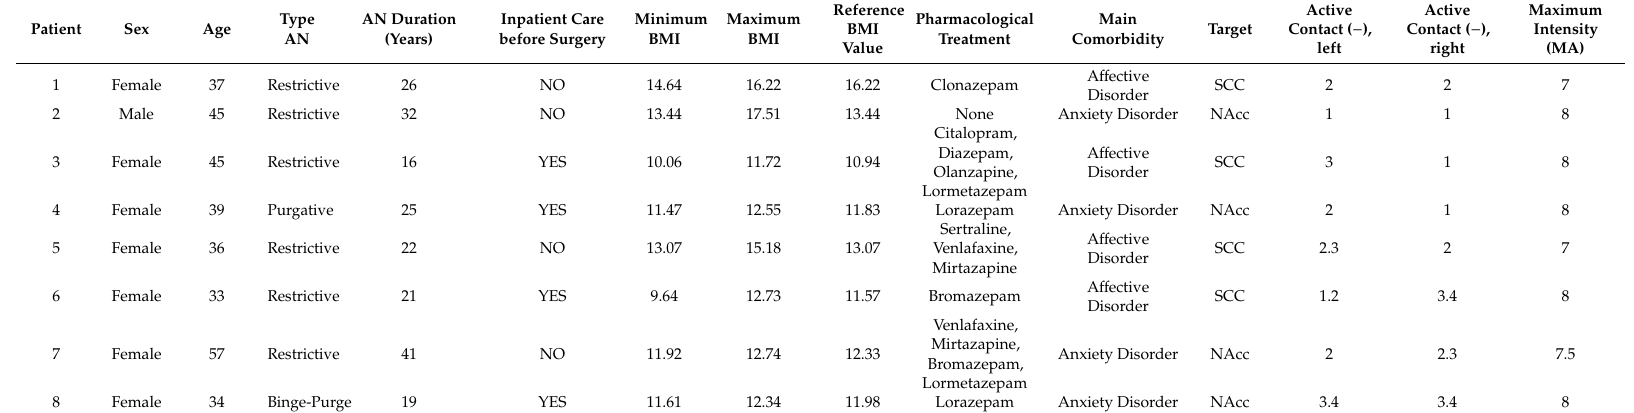
Table 1. Participant’s demographic and clinical characteristics, active contacts, and stimulating